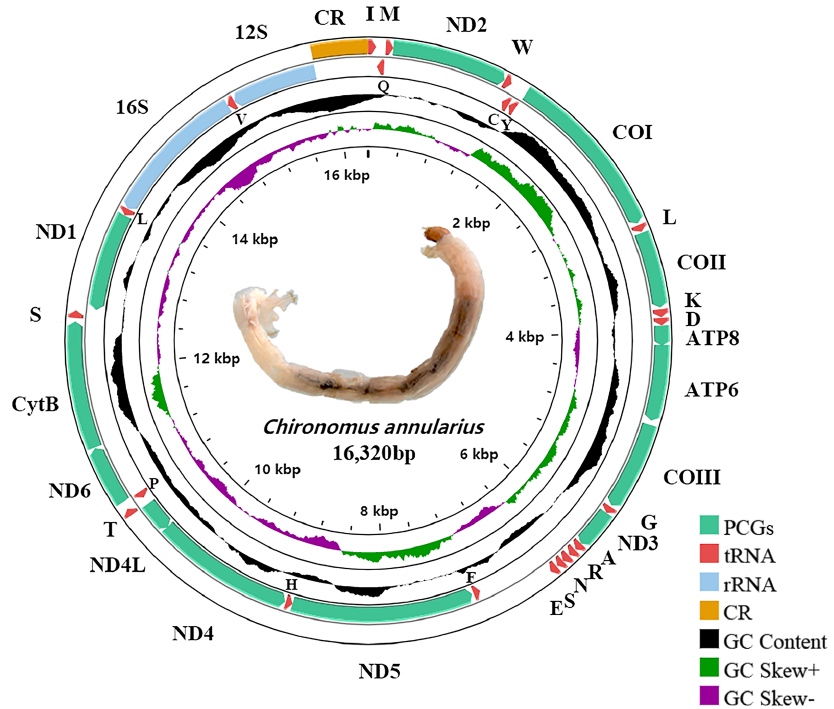
Figure 1. Mitogenome map of representative species of Chironomus ( Chironomus annularius ). The arrow indicates the direction of gene transcription. PCGs and rRNAs are represented by normative abbreviations, while tRNAs are represented by single-letter abbreviations. In the notes at the bottom right, green, red, blue, and yellow respectively corresponded to PCGs, tRNAs, rRNAs, and CR. The second circle shows the G+C content of the complete mitogenome. The third circle exhibits the GC-skew of the whole mitogenome. The innermost circle shows the morphology of the larvae of Chironomus annularius and the length of the